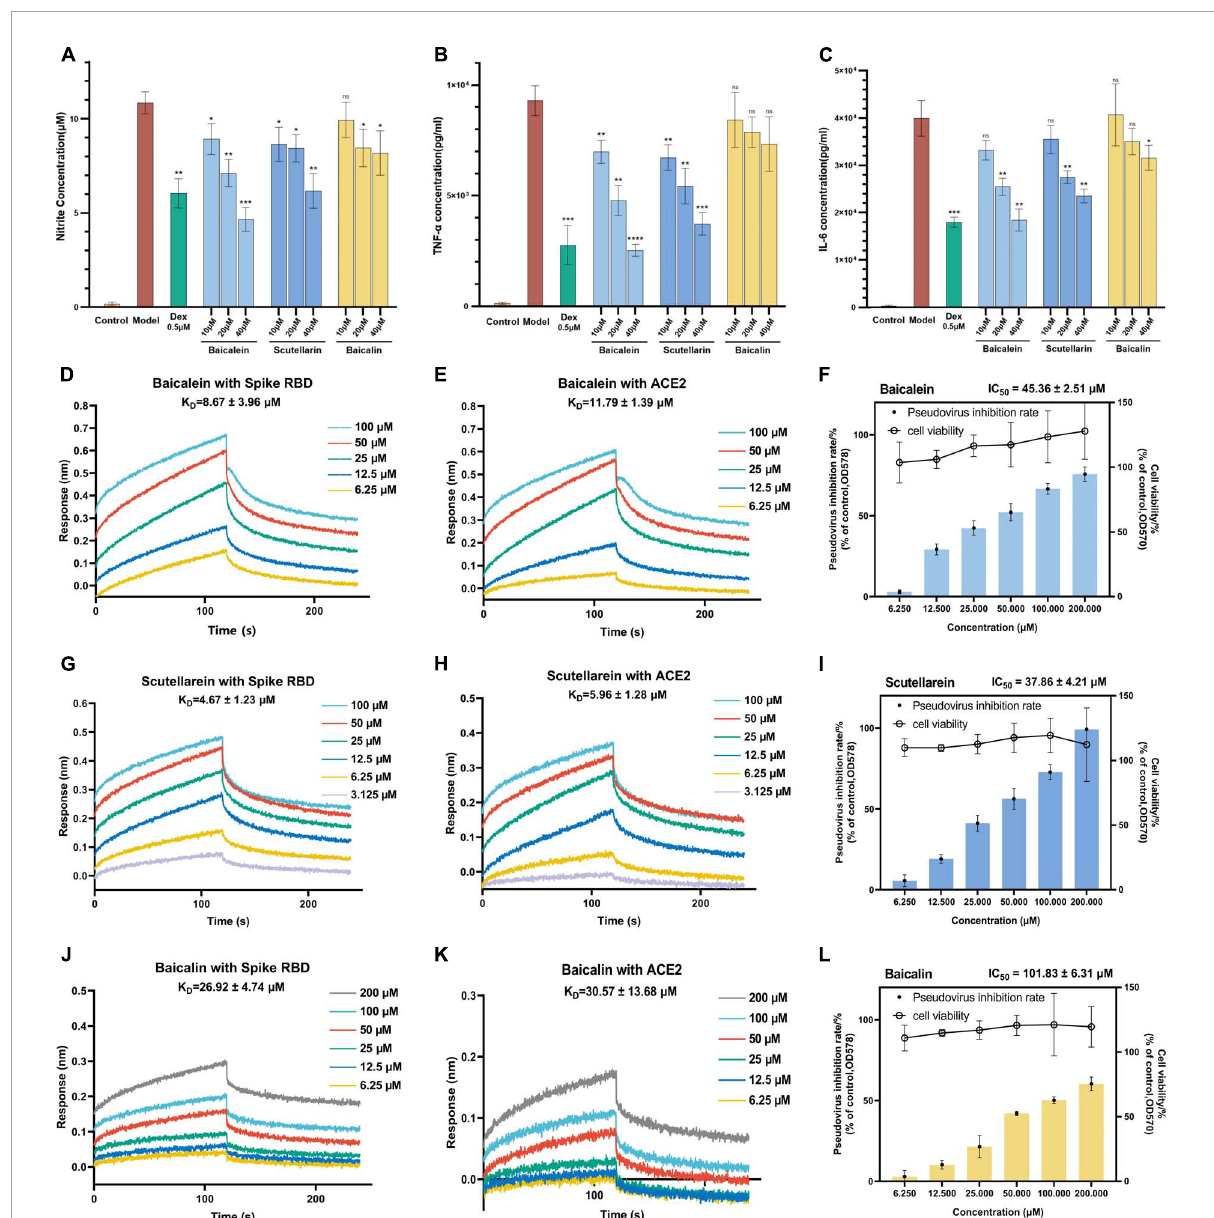
FIGURE8 In vitro experiments confirmed that baicalein and scutellarein are main active anti-COVID-19 components in KuQin. (A–C) Effects of baicalein, scutellarein, and baicalin on the levels of NO, TNF- α , and IL-6 in LPS-stimulated RAW264.7 cell. The concentrations of NO, TNF- α , and IL-6 in culture medium were quantified by Griess Reagent System or ELISA assay. (D,E,G,H,J,K) Binding curves of baicalein, scutellarein and baicalin with SARS-CoV-2 spike RBD and human ACE2 receptor. (F,I,L) Baicalein, scutellarein and baicalin inhibited the entrance of SARS-CoV-2 pseudovirus into host cells. All the experiments were repeated three times. * p < 0.05, ** p < 0.01, *** p < 0.001, **** p < 0.0001, compared with model